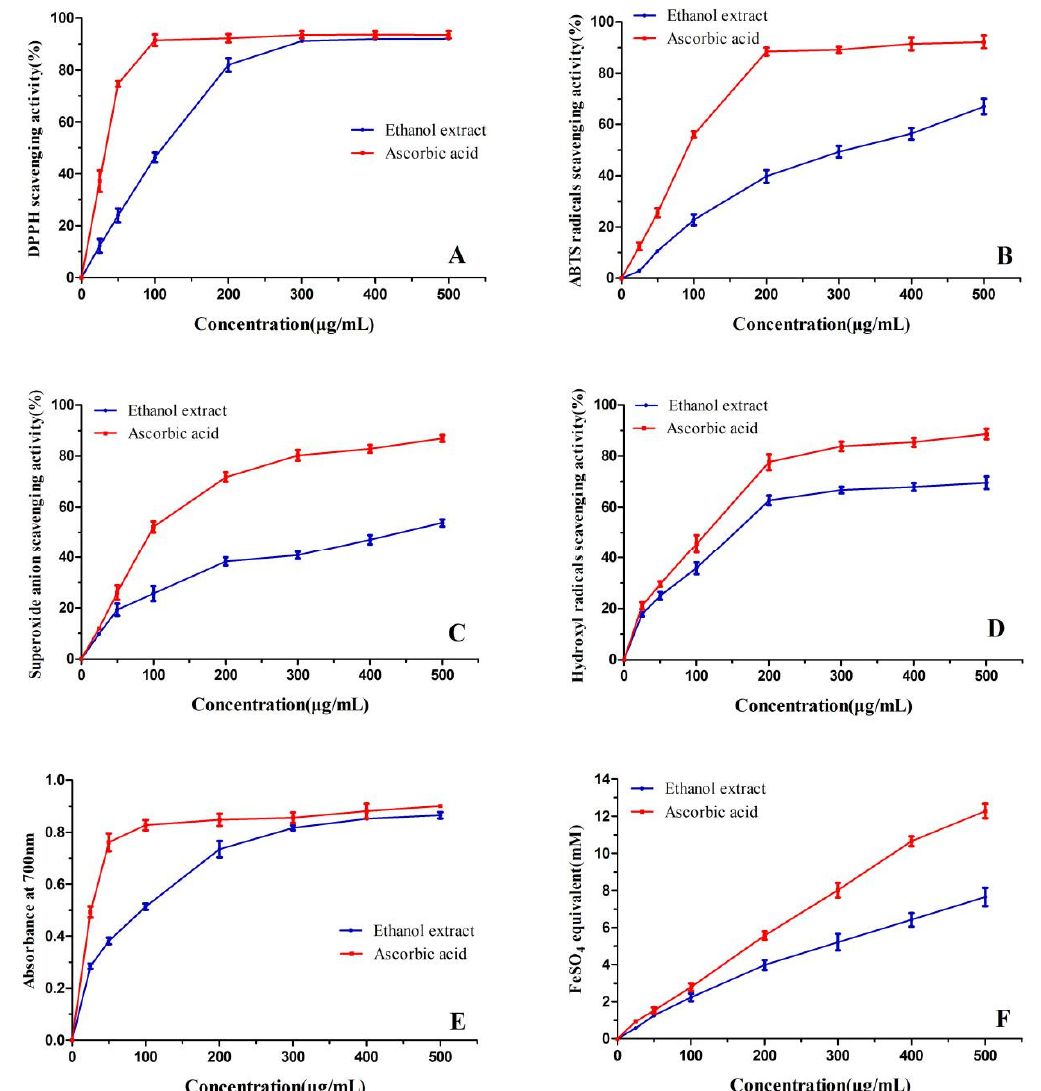
Scavenging activities on 1,1-diphenyl-2-picrylhydrazyl (DPPH) ( A ), 2,2 (cid:48) -Azinobis- (3-ethylbenzthiazoline-6-sulphonate) (ABTS) ( B ), superoxide radicals ( C ), hydroxyl radicals ( D ), reducing power ( E ) and ferric reducing antioxidant power (FRAP) ( F ) of the bark extract of T.